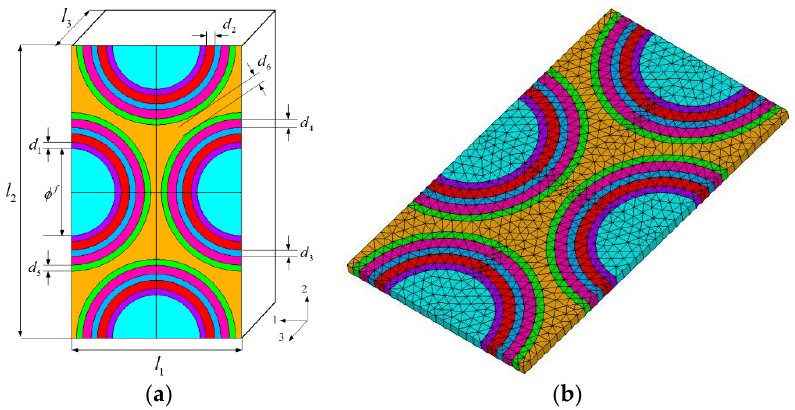
Figure 2. Unit cell of the unidirectional C/C–SiC composites: ( a ) Geometrical model; ( b ) Finite element model.